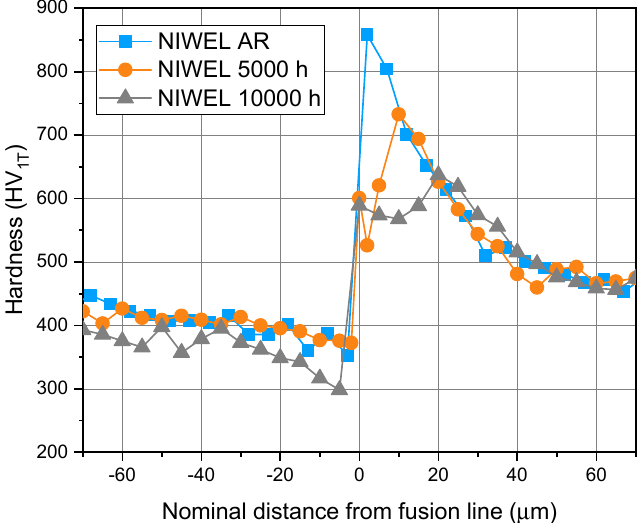
Figure 14. Comparison of the nanoindentation hardness profiles of NIWEL AR, NIWEL 5000 h and NIWEL 10,000 h at the LAS/Alloy 52 weld metal interface.